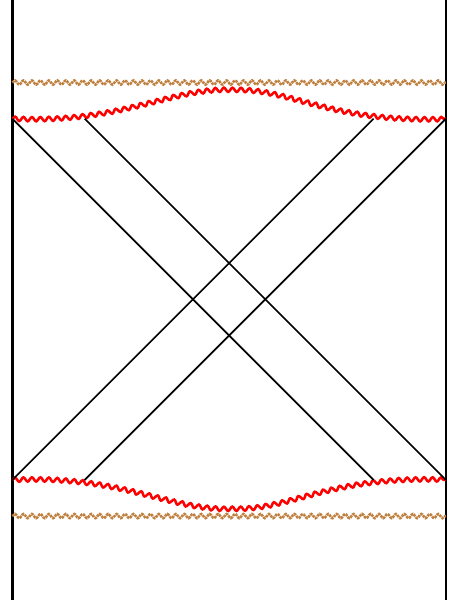
Figure 2 . We depict the deformation of the Penrose diagram with initial perturbation of